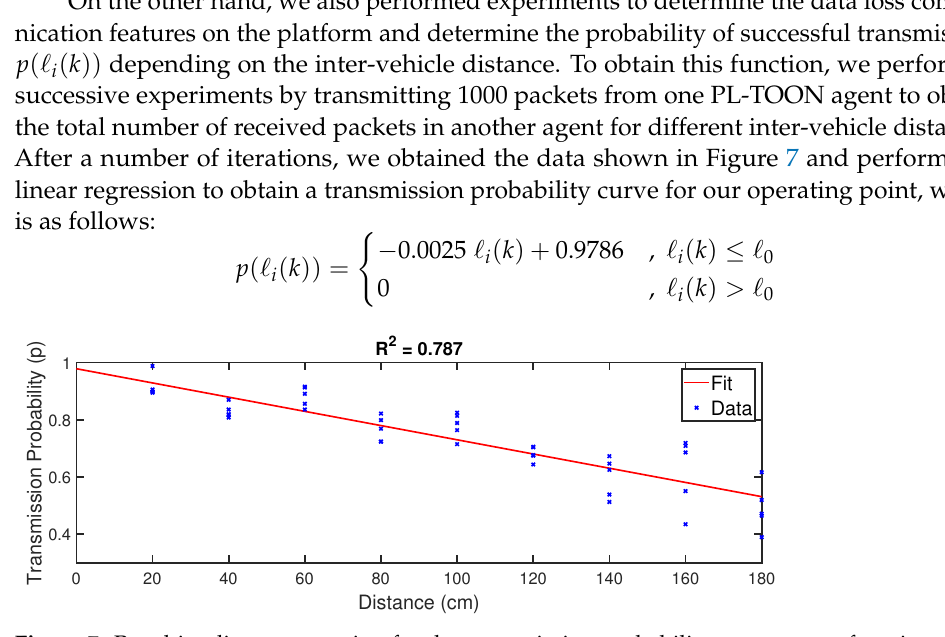
Figure 7. Resulting linear regression for the transmission probability p curve as a function of the separation distance (cid:96)